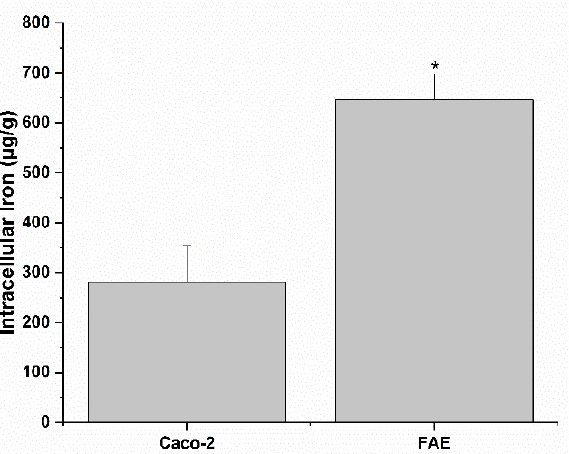
Figure 4. Intracellular Fe concentration ( µ g/g cellular proteins) in Caco-2 and human intestinal follicle-associated epithelium (FAE) monolayers at the end of the 3 h incubation with bioaccessible fractions of Ferro Fosfosoma ® . * p < 0.05. Table 5. Intracellular Fe levels in Caco-2 and human intestinal follicle-associated epithelium (FAE) monolayers at the end of the 3 h incubation with bioaccessible fractions of Ferro Fosfosoma ® . Results are expressed as mean ± standard deviation.